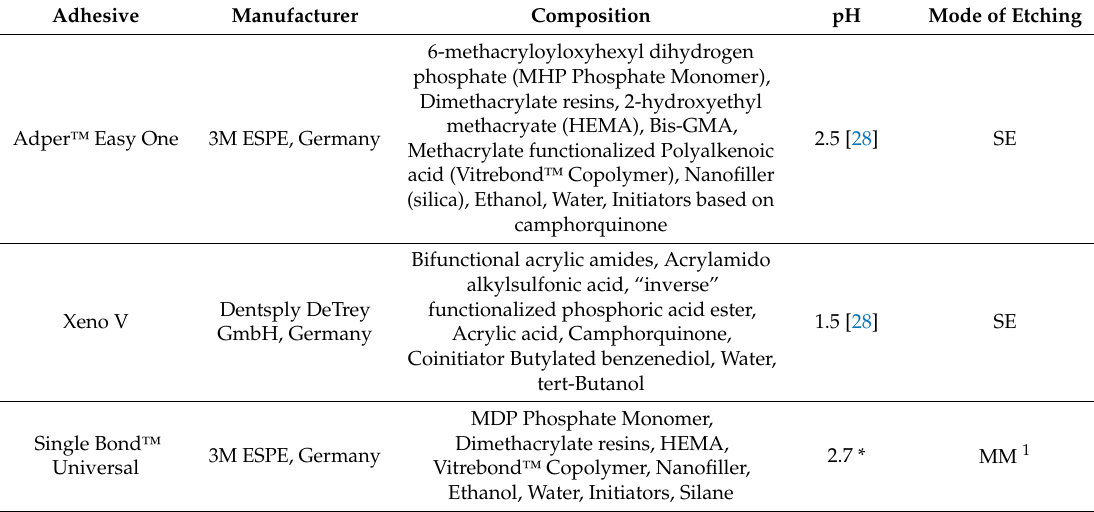
Table 1. Dental adhesives used in the